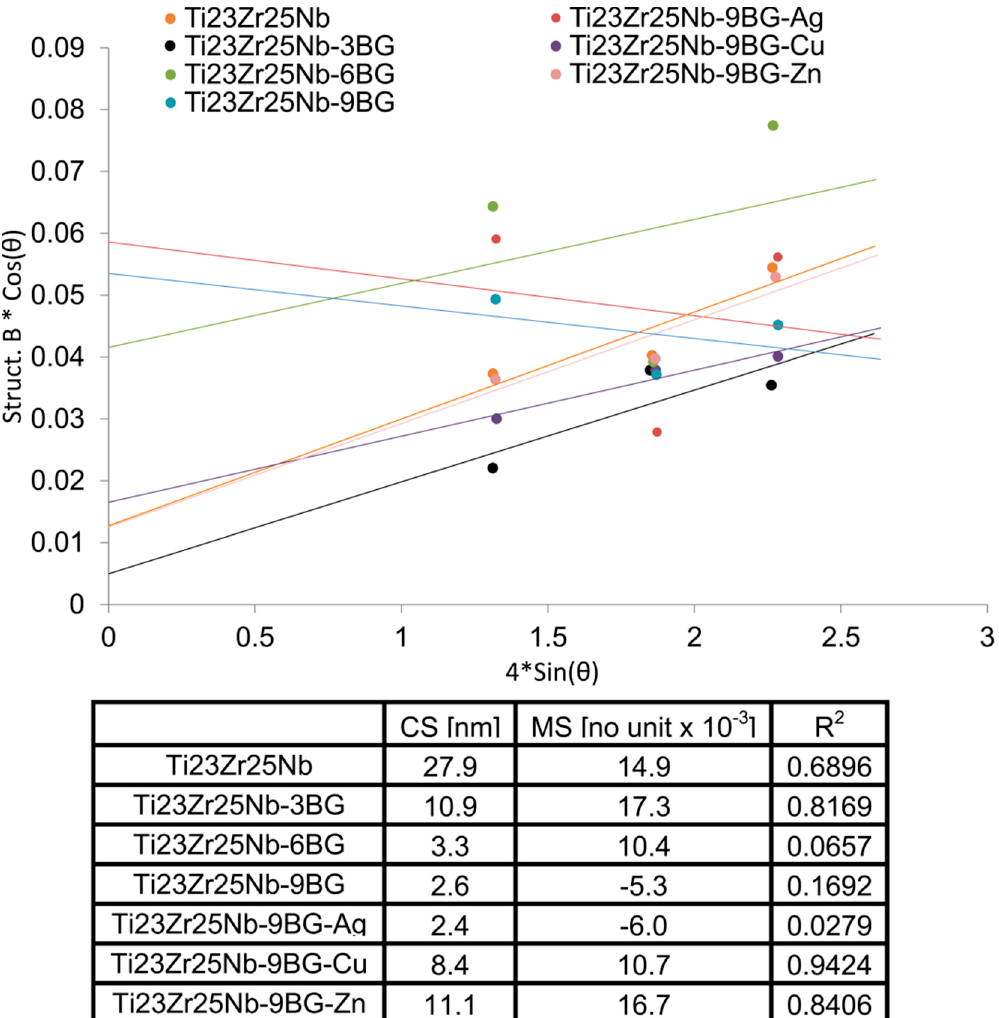
Figure 3. Linear Williamson–Hall plots with estimated crystallite size (CS) and microstrain (MS) factors based on the XRD spectra of Ti23Zr25Nb-based composites powders after 16 h of mechanical alloying in contrast to the mechanically alloyed Ti23Zr25Nb alloy for 10 h.